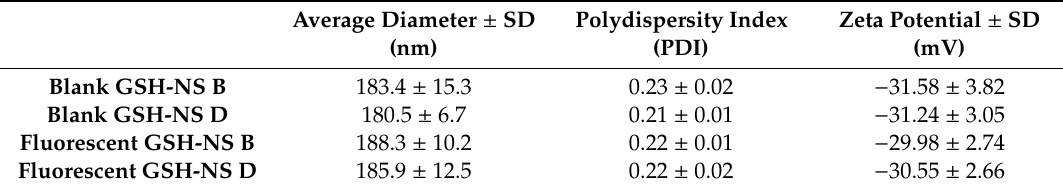
The physico-chemical characteristics of glutathione-responsive β -cyclodextrin-based nanosponge (GSH-NS)